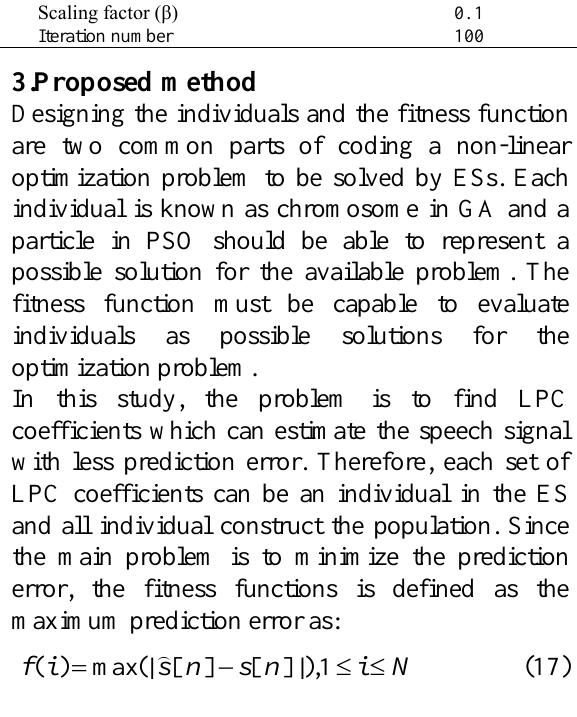
Modeling description setting Swarm